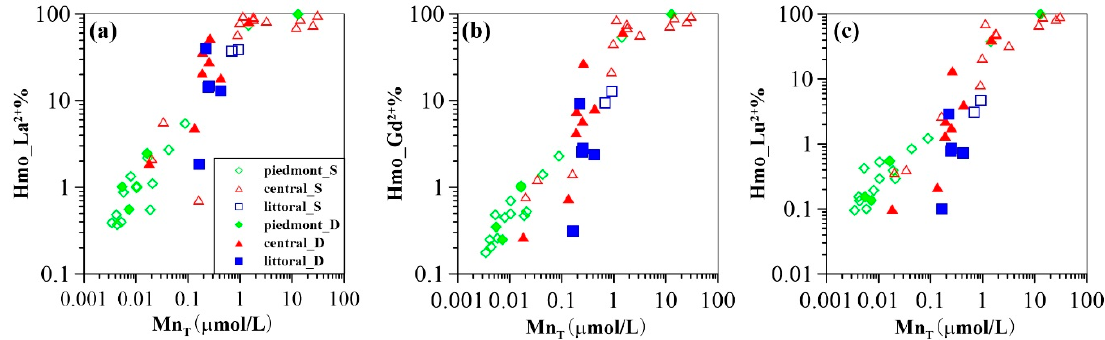
Figure 8. Proportion of La ( a ), Gd ( b ), and Lu ( c ) binding with HMO as a function of Mn T concentrations.